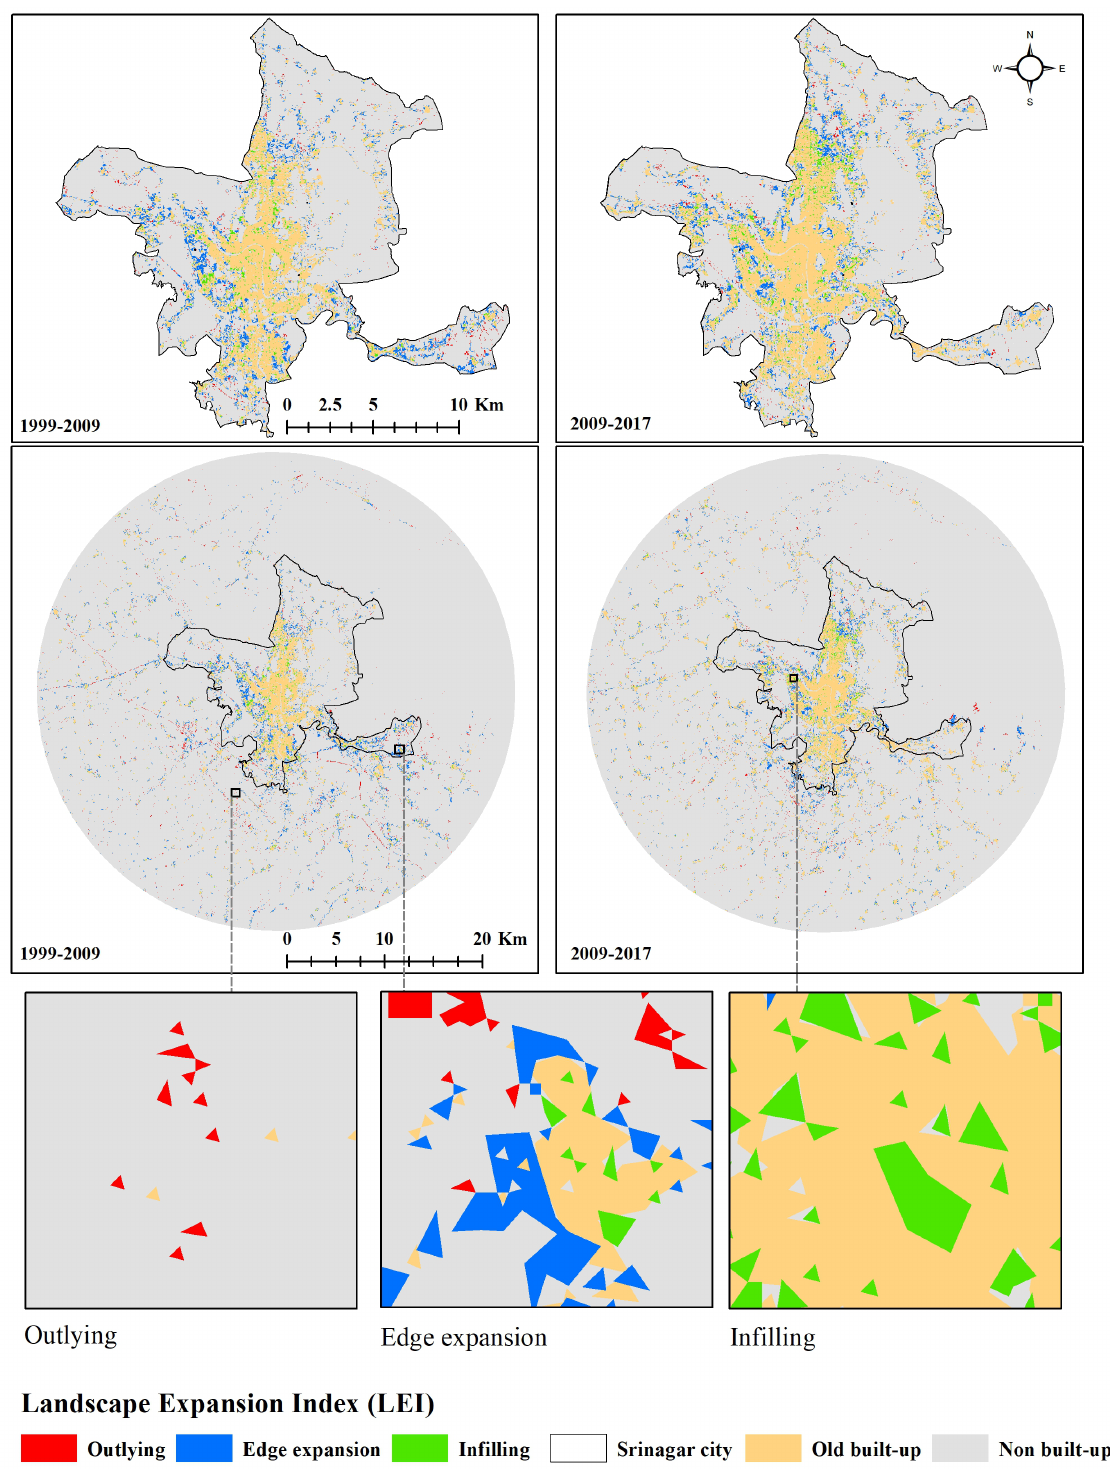
Figure 15. Spatiotemporal distribution of growth types in T 1 (1999–2009) and T 2